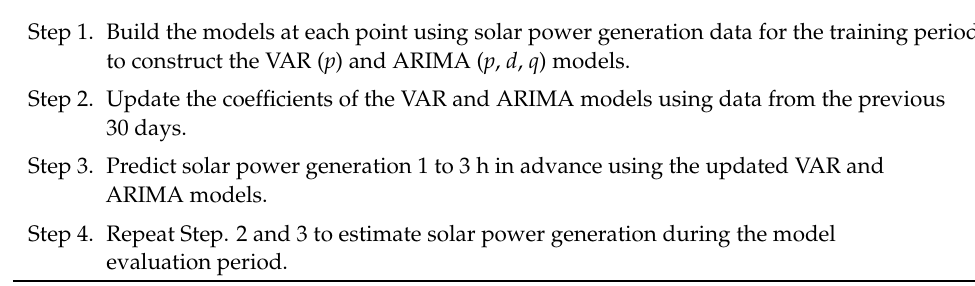
Algorithm 1: The prediction algorithm for solar power generation using the VAR and